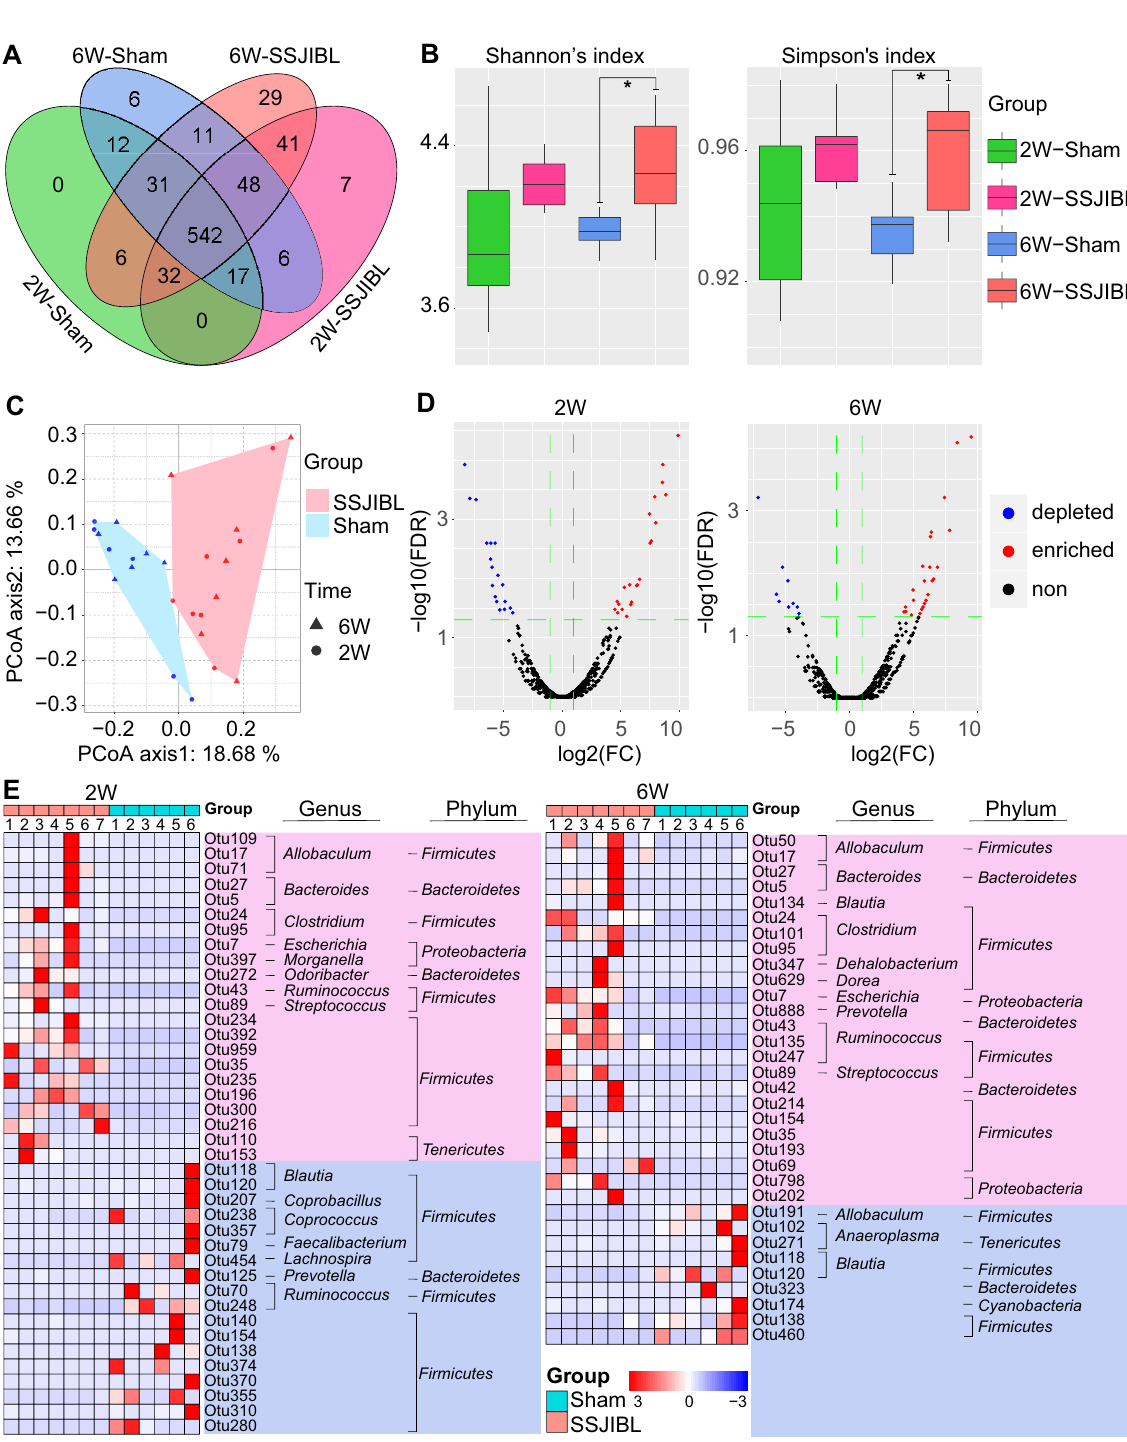
Figure 3. SSJIBL altered the gut microbiota composition of GK rats in a time-dependent manner. ( A ) Venn map. ( B ) α diversity of gut microbiota. ( C ) Bray curtis PCoA analysis of gut microbiota based on the OTU data of Sham and SSJIBL groups. ( D ) Volcano map of different OTUs. ( E ) Heatmap of the different OTUs altered by SSJIBL treatment. The color of the spots in the left panel represents the relative abundance of the OTU in each group. The phylum, and genus names of the OTUs are shown on the right panel. The analyses were conducted using R software version